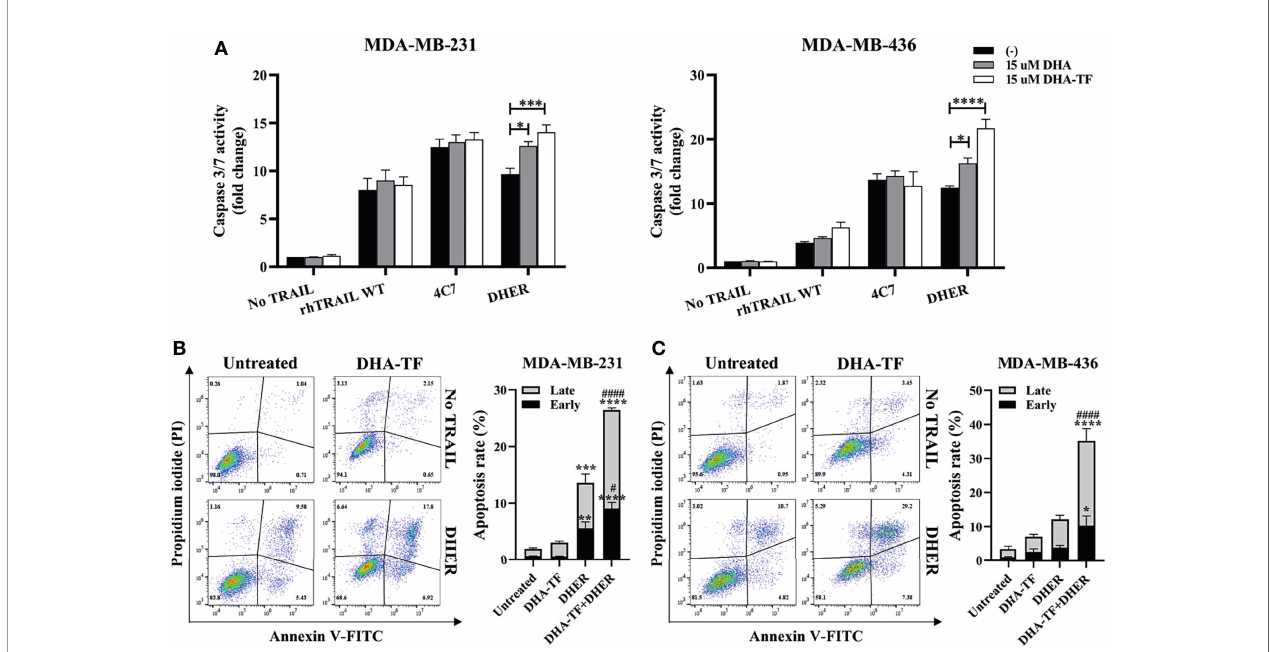
FIGURE 6 | DHA-TF enhances DHER-induced apoptosis through caspase cascade. (A) DHA-TF in combination with DHER signi fi cantly enhances caspase3/7 activity in MDA-MB-231 and MDA-MB-436. Luminescence was measured after 1 h reagent incubation. Data shown are mean ± SEM from three independent experiments performed in triplicate. The cell apoptotic assays were performed in MDA-MB-231 (B) and MDA-MB-436 (C) after 20 h treatment. Statistical analysis was based on three independent experiments and is shown on the right side. In (B, C) , the * represents the comparison with untreated cells, and the # represents the comparison with DHER treated cells. *0.01 < p ≤ 0.05, **0.001 < p ≤ 0.01, ***0.0001 < p ≤ 0.001, ****p ≤ 0.0001, # 0.01 p ≤ 0.05, #### p ≤